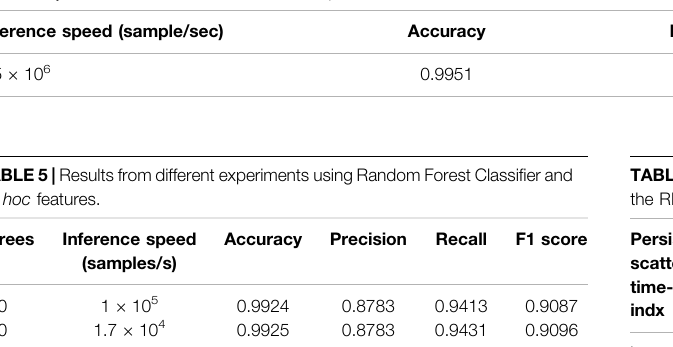
TABLE 4 | Results from the neural network experiment.